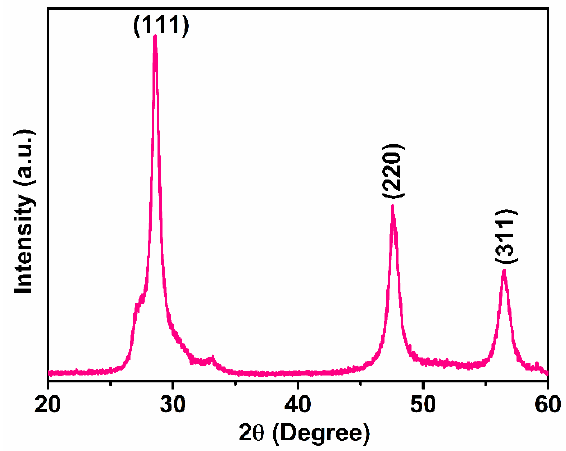
Figure 1. X-ray diffraction (XRD) spectrum of the as-prepared ZnS quantum dots.